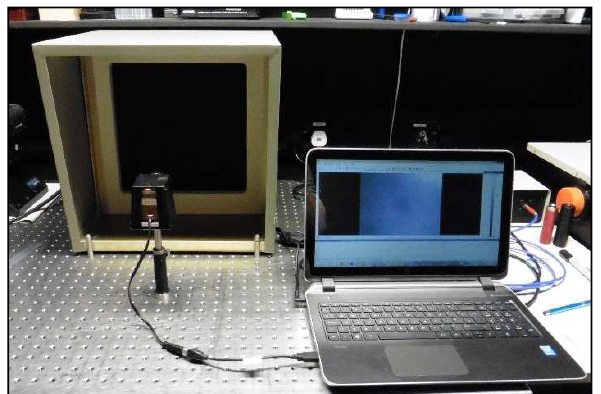
Figure 2. Camera calibration against a blackbody.